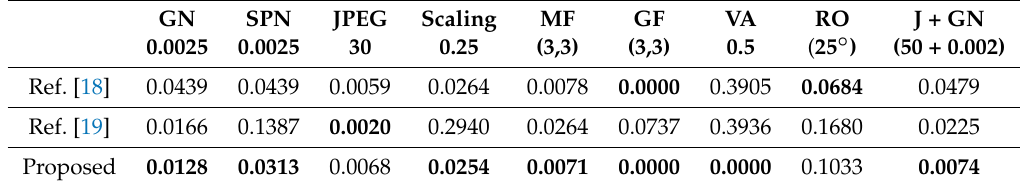
Table 7. Average BER values with PSNR = 42 dB between Ref. [18], Ref. [19] and our proposed scheme under different